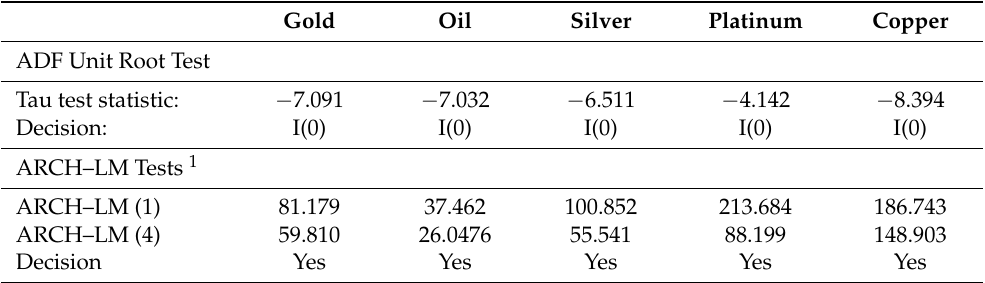
Table 2. Unit root and ARCH–type heteroskedasticity test results.